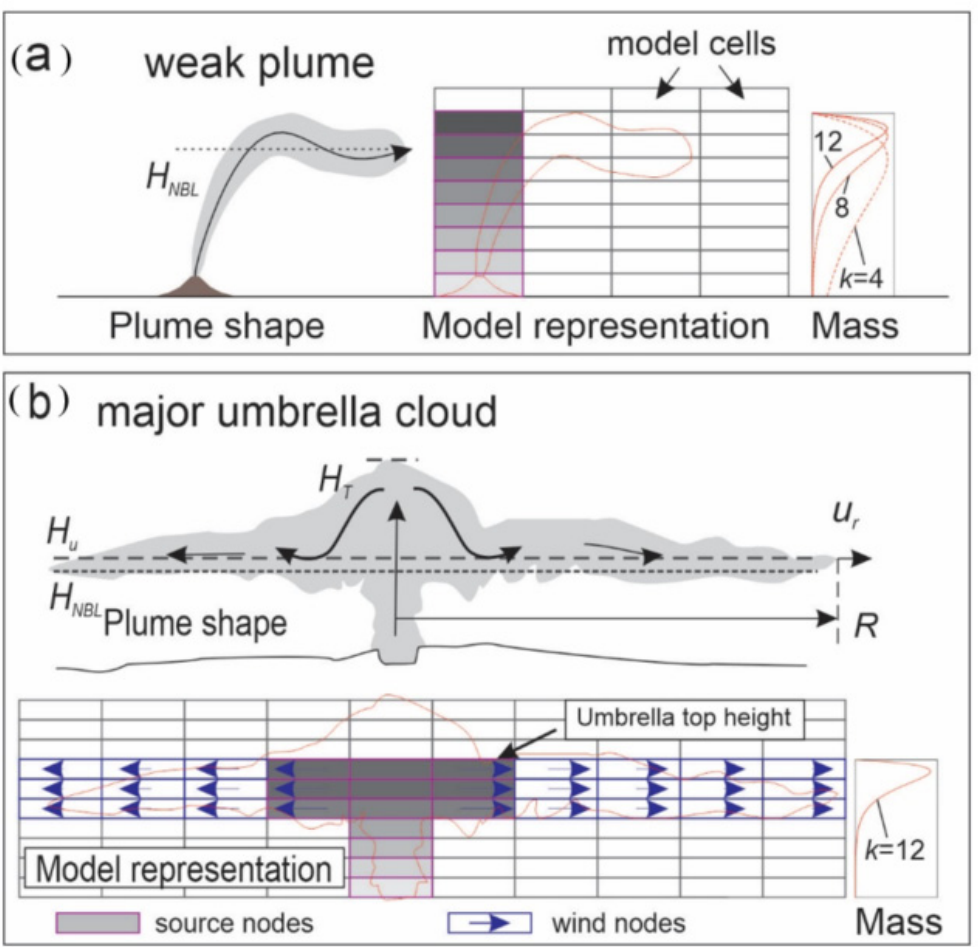
Figure 1. ( a ) illustration of the conventional configuration of source nodes in a Eulerian volcanic ash transport and dispersion (VATD) model. A weak bent plume ( left ) is represented as a column of source nodes ( center ) that lie vertically above the vent. The darkness of each source node in the figure represents the relative mass added to each node. Red curves to the right represent the vertical distribution of mass with height as specified using a Suzuki function with k = 4, 8, and 12, respectively. ( b ) Depiction of the configuration of source nodes in the Ash3d model with an umbrella cloud. The source nodes in the model extend only to the top of the umbrella cloud (gray cells in lower figure). From the ground level to the base of the umbrella, the source nodes consist of a single column of nodes. Within the umbrella, the source nodes consist of a cluster, 3 × 3 nodes in map view, with enough nodes in the vertical dimension to extend from 75% to 100% of the umbrella-top height. A radial wind (blue arrows) is added to cells within the cloud, extending from the cloud center to its margins, with a wind speed specified by Equation (3) or (4). The vertical distribution of mass in the source nodes is given by a Suzuki function with k = 12 (red curve at lower